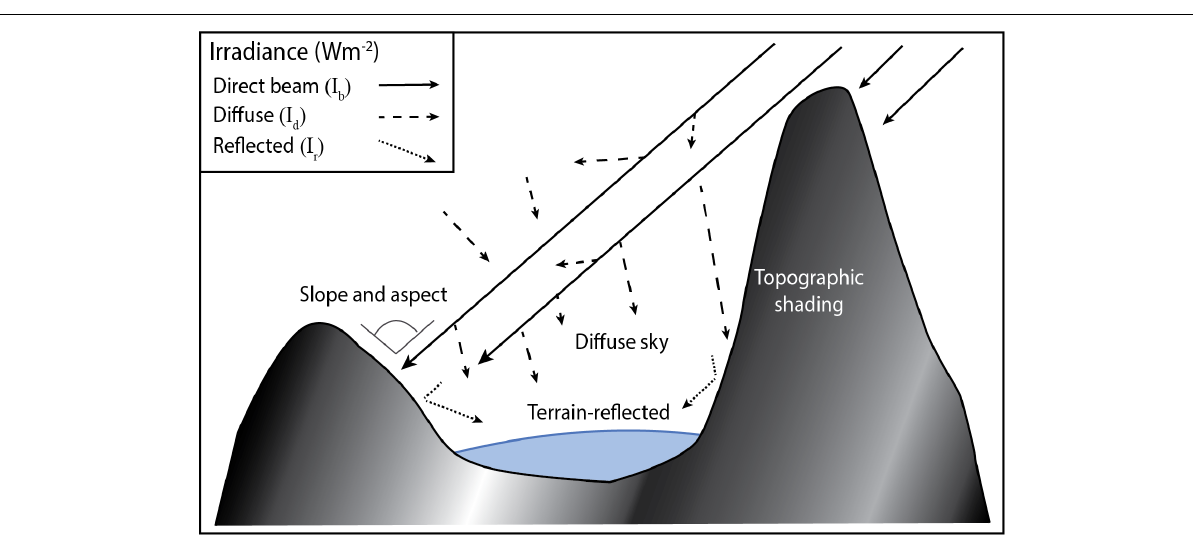
FIGURE 2 | Schematic showing how the three components of incident shortwave radiation — direct (I b ), diffuse (I d ), and reflected (I r ) irradiance — are altered by terrain. Topography alters shortwave radiation at the surface through the slope and aspect (generally combined), topographic shading, a decrease in the amount of diffuse sky radiation, and an increase in terrain-reflected